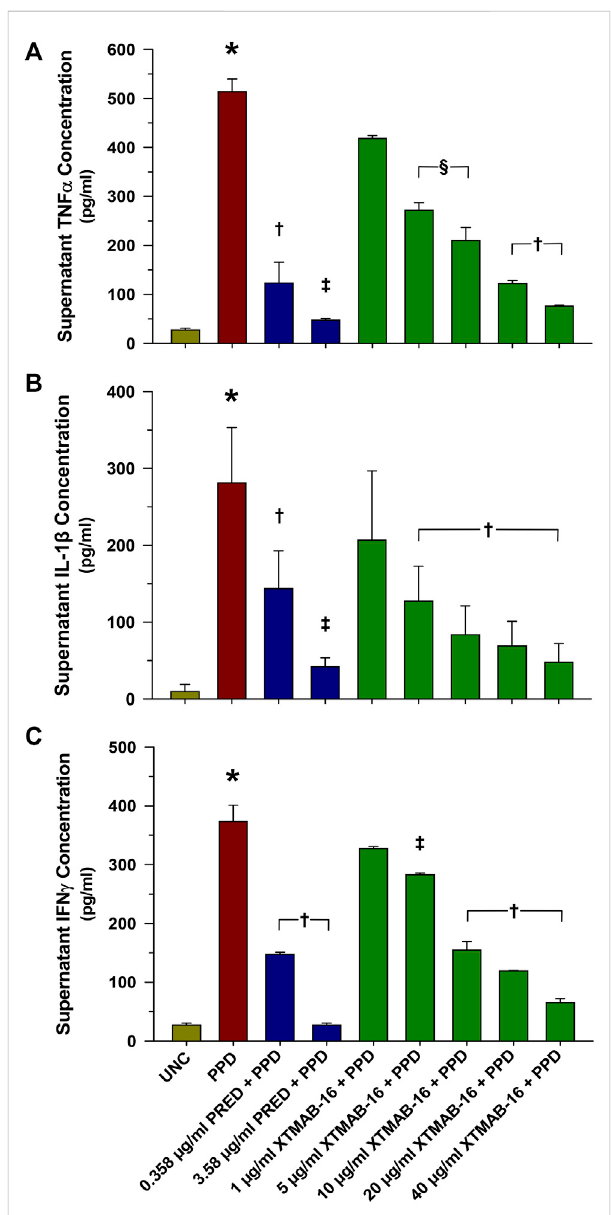
FIGURE 2 Group Supernatant TNF α (A) , IL-1 β (B) , and IFN γ (C) Release in High Responder Patients (as De fi ned by Having > 2% Granuloma Area Fraction) With Sarcoidosis. Note: n = 6 for each group; * p < 0.001, compared to the uncoated bead (UNC) treatment group; † p < 0.01, ‡ p < 0.001( p < 0.05inbottom),and§ p < 0.05relativetothePPD- treated group. Bars are mean ( μ g/mL)±SD. Abbreviations: IFN = interferon; IL = interleukin; PPD = puri fi ed protein derivative; PRED